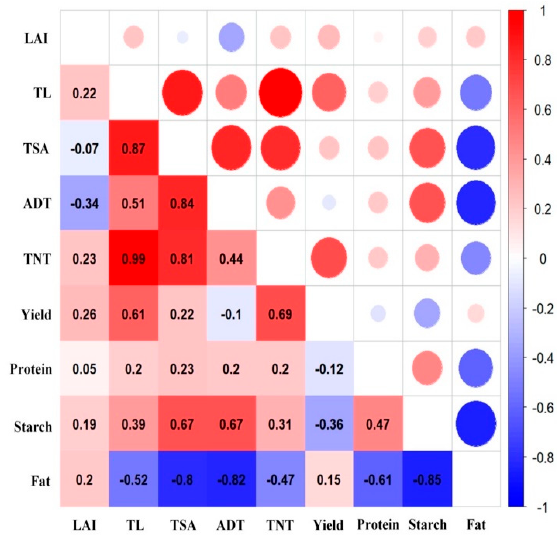
Figure 8. The heat map of correlation between each pair of indices (i.e., root, grain yield, and quality) after drought–flood abrupt alternation in summer maize farmland systems. The blue discs represent the negative correlation between the pair of indices, with the value of –1. The red discs represent the positive correlation between the pair of indices, with the value of 1. Note: LAI represents the leaf area index; TL represents the total length of root; TSA represents the total surface area of root; ADT represents the average diameter of root tips; TNT represents the total number of root tips; yield represents the grain yield; protein represents the grain crude protein; starch represents the grain starch; fat represents the grain crude fat.